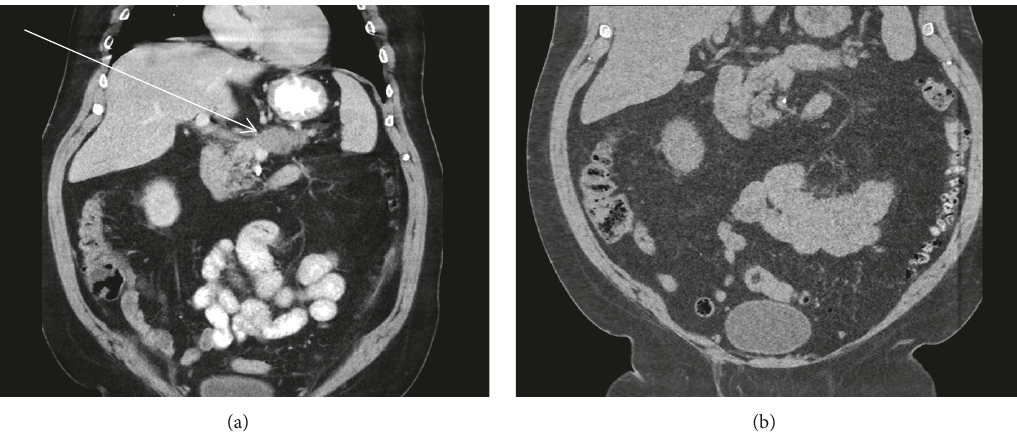
Figure 2: (a) Computed tomography scan with intravenous contrast, which showed 5.0 × 2.7 cm irregular, ill-defined, and hypoattenuating mass located in the pancreatic tail and body (labelled as thin arrow). (b) The prior noncontrast computed tomography scan four months earlier showed no lesions in the pancreas and